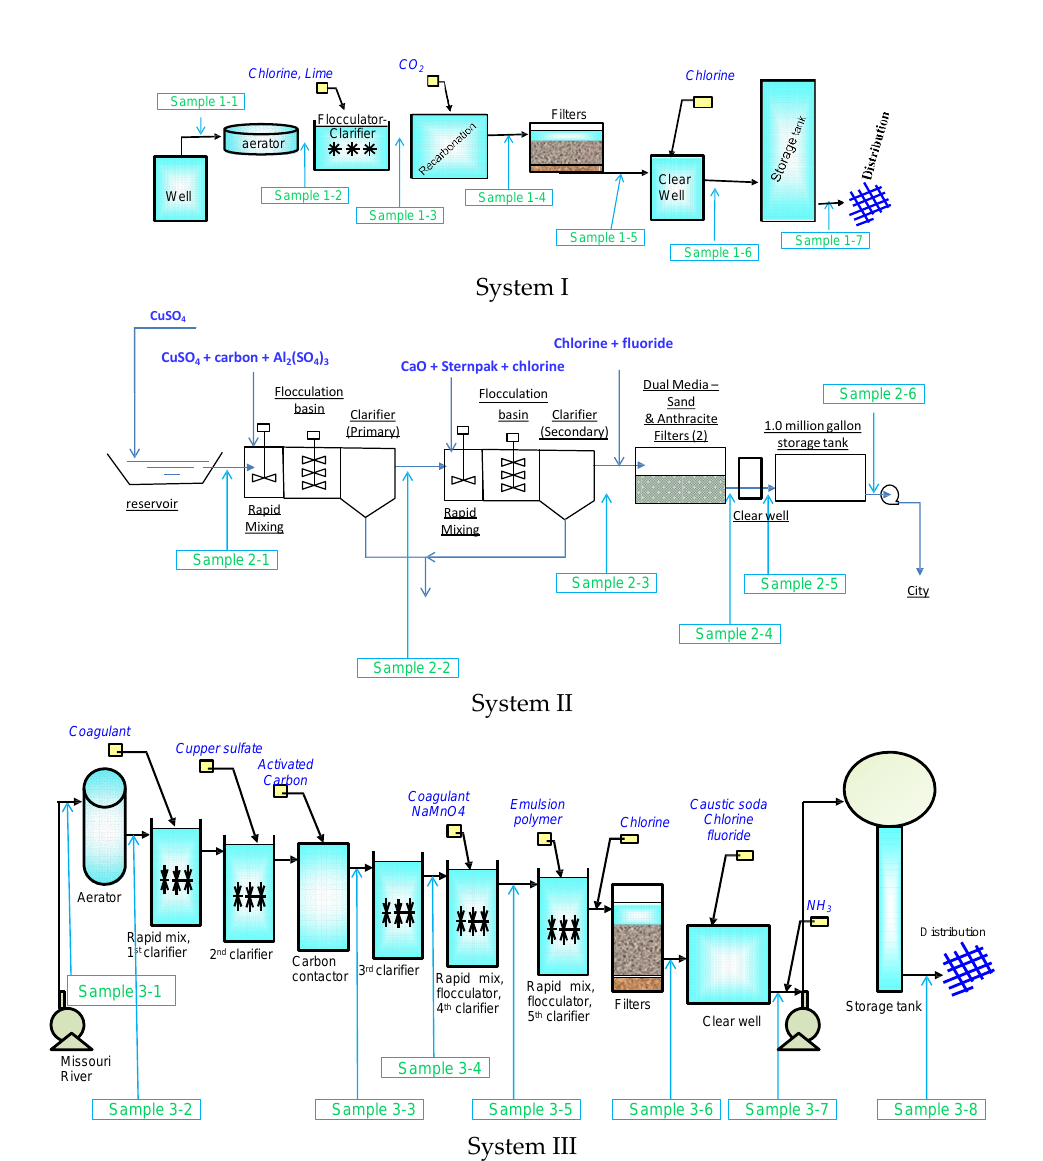
Figure 1. The schematics of treatment operation trains and sampling sites at each of the selected small systems.